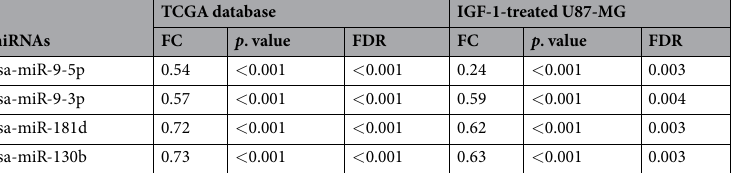
Table 1. Downregulated miRNAs in miRNA arrays from TCGA database and IGF-1-treated U87-MG cells. FC: Fold change; FDR : False Discovery